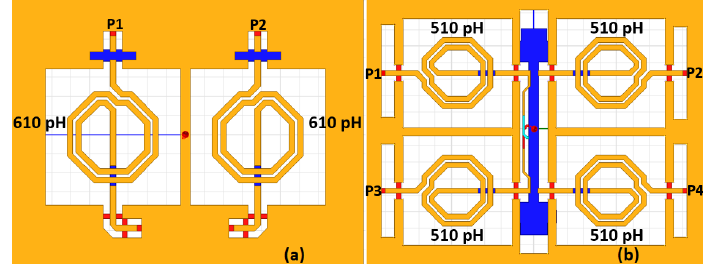
Figure 6. The passive structure of the SPDT ( a ) and DPDT ( b ) switches simulated with HFSS.